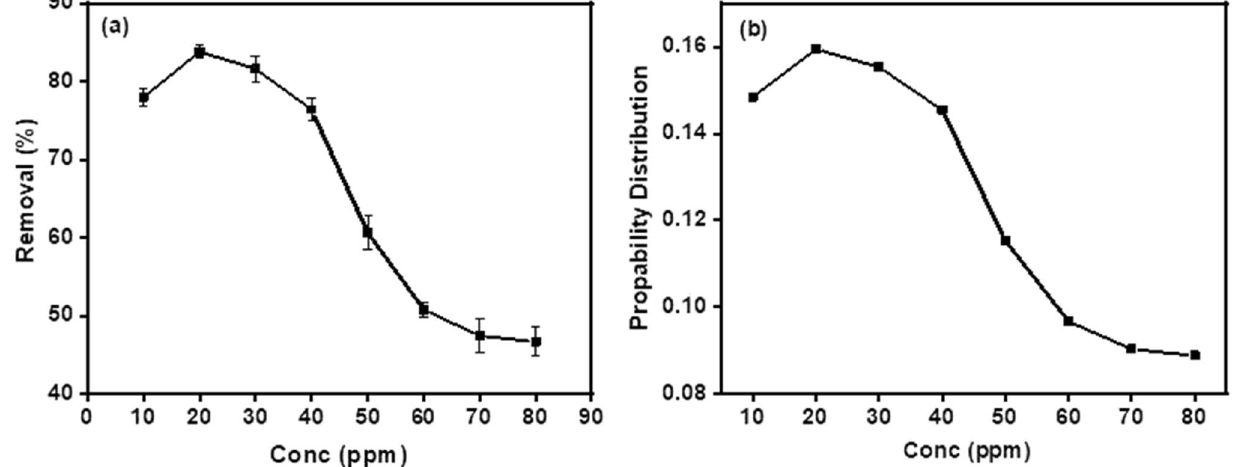
Fig. 11 a Effect of Concentration on adsorption process by His-MMt b PDF of concentration